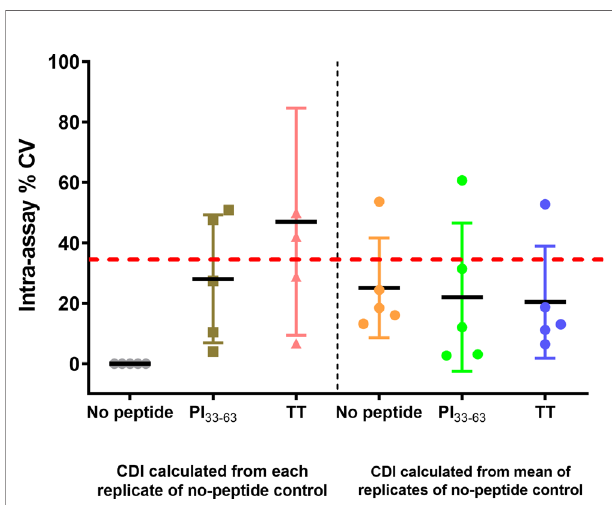
FIGURE 8 | CD4 + CDI to PI 33-63 and TT using freshly isolated PBMC from fi ve patients with T1D ≤ 3 months, measured by a single analyst. From the mean CDI of triplicate measurements, the % Coef fi cient of Variation (CV) was calculated. Each data point represents % CV. Solid lines represent mean % CV (intra-assay repeatability). The dashed red line indicates the recommended threshold limit of CV ≤ 35%